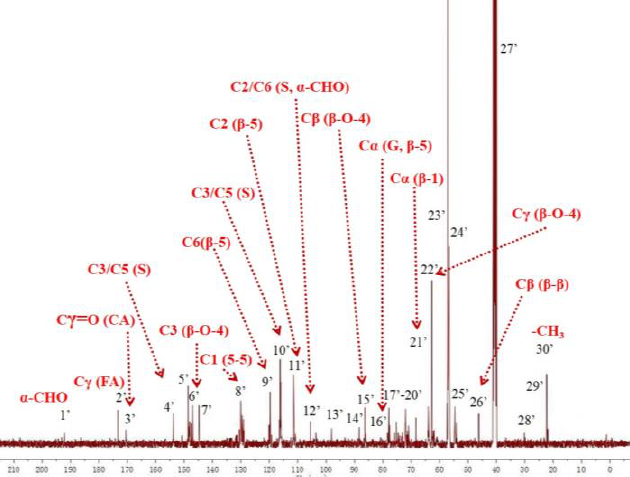
Figure 2. 13 C-NMR spectrum of DHP-GS.